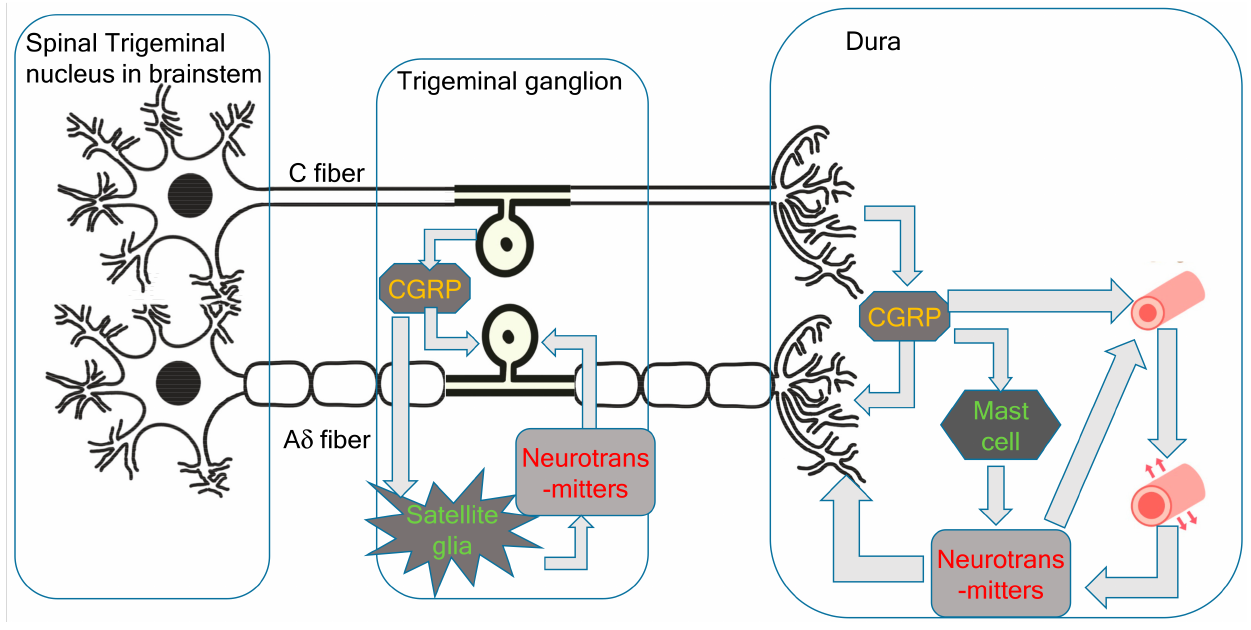
Figure 1. Peripheral pathophysiology of